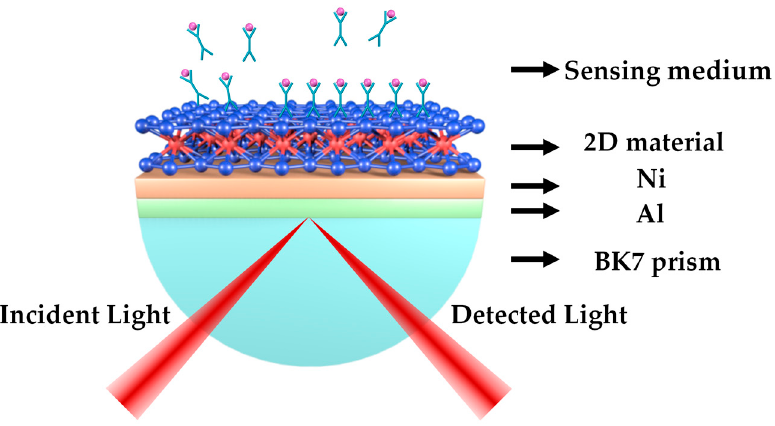
Figure 1. Schematic diagram of the proposed SPR sensor. Table 1. Thickness and refractive index of 2D materials at the wavelength of 633 nm. Material Thickness of Monolayer